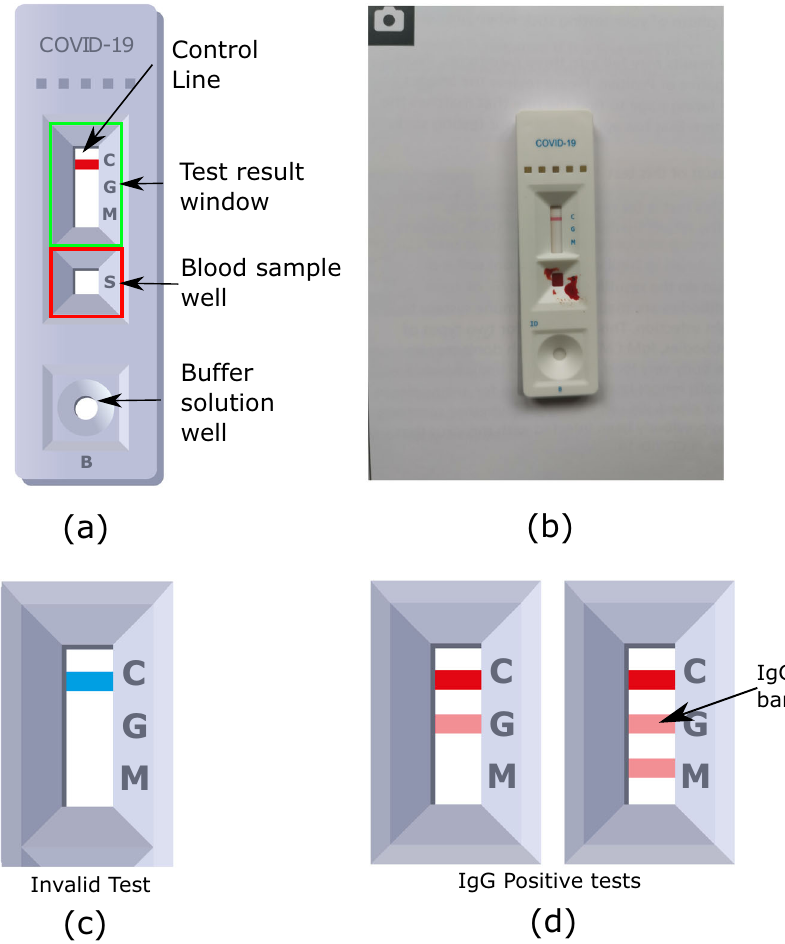
Fig. 1 Key visual features of the Fortress SARS-CoV-2 Lateral Flow Immunoassay (LFIA) device. a Diagram illustrating the test result window and blood sample well. This diagram shows a negative Immunoglobin G (IgG) test. b Example of a participant-submitted photographic image of a negative IgG test. c The result window has an initially blue control line, which will remain if the test is unsuccessful (Invalid). d In a successful test, the control line turns